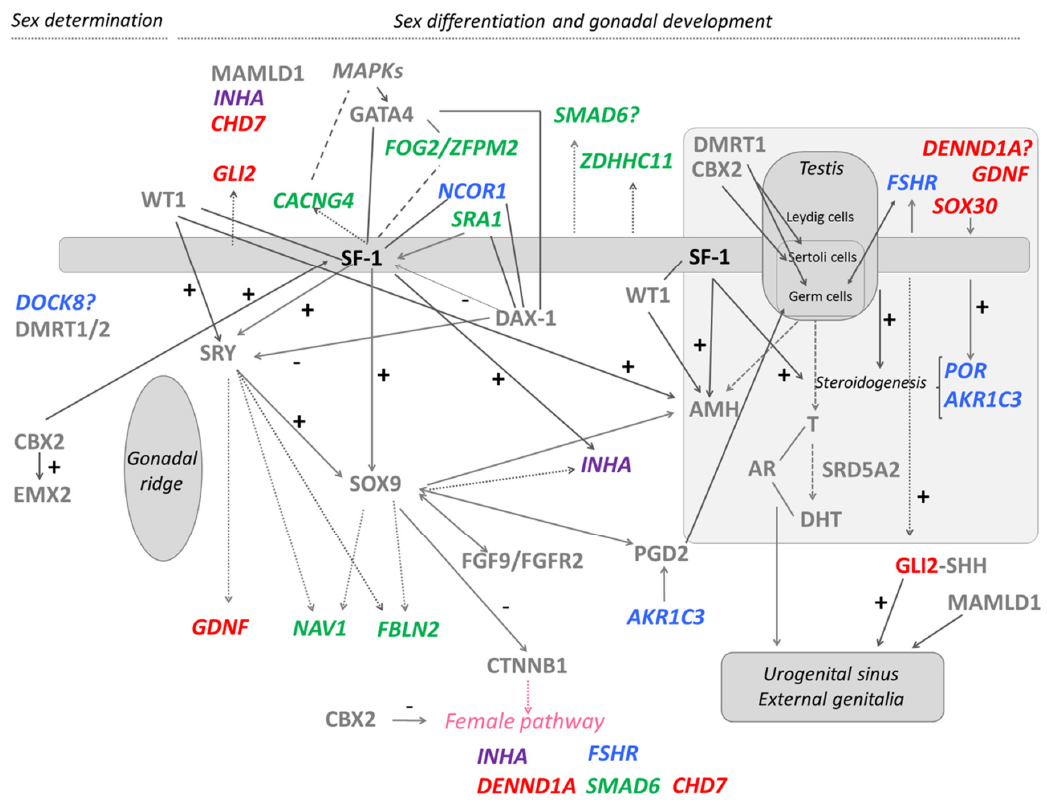
Figure 1. Additional genetic variants identified in four 46,XY patients with disordered/different sex development harboring heterozygous NR5A1 /SF-1 disease-causing variants depicted with respect to the known pathways of male sex determination and differentiation. The scheme shows an overview of involved genes and their interrelationship. It emphasizes on SF-1, which seems to play an important role throughout all developmental processes (indicated by a thick line). Genes with variants identified by whole exome sequencing in the patients have specific colors. In violet: candidate gene in patient 1; in blue: candidate genes in patient 2; in green: candidate genes in patient 3; in red: candidate genes in patient 4; in grey: known genes involved in sexual development. Interrogation mark (?): function/timing/location is not clear; arrows: regulation/co-activation; dotted arrows: genes with binding regions for SF-1, SRY, and/or SOX9; lines: interaction/partnership; dashed lines: related genes, but thus far unclear how exactly; thick dashed arrows: hormone production. Modified from